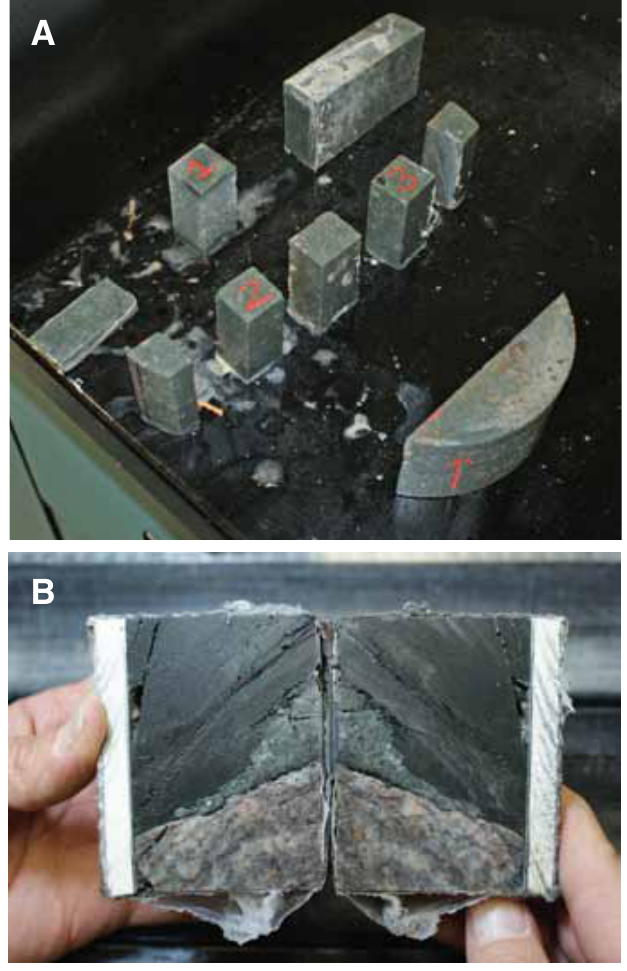
Fig. 3: Photos by Bradley Weymer, IODP and SAFOD, Texas